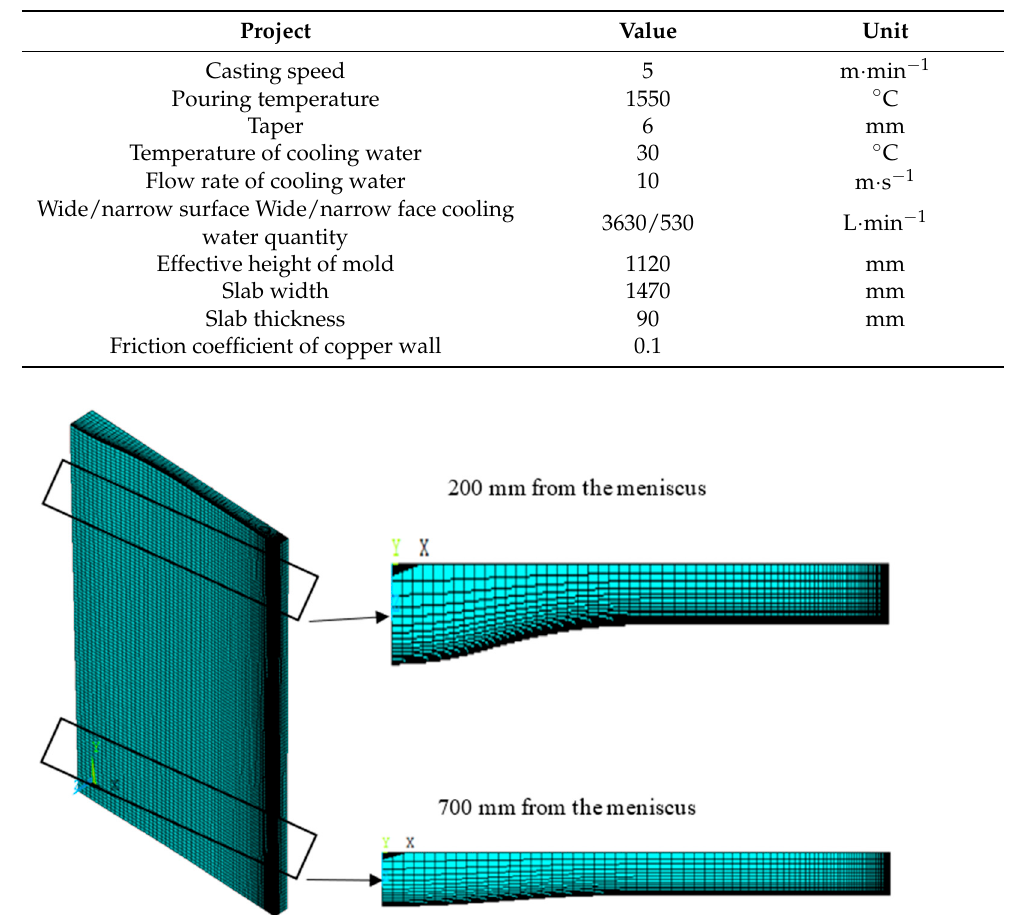
Figure 1. The 3D stress finite element model.